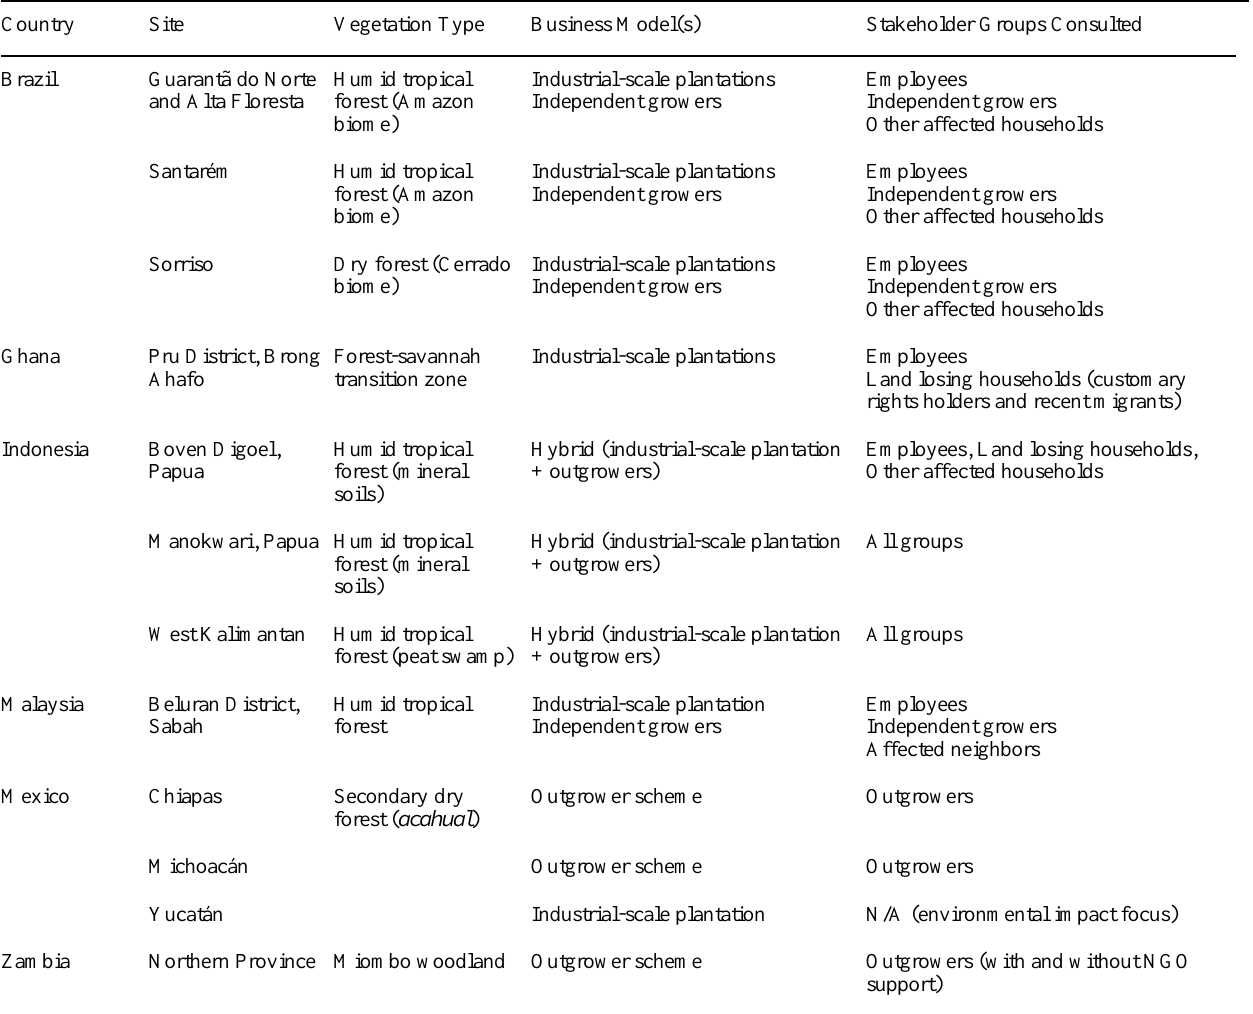
Table 1 . Overview of research sites